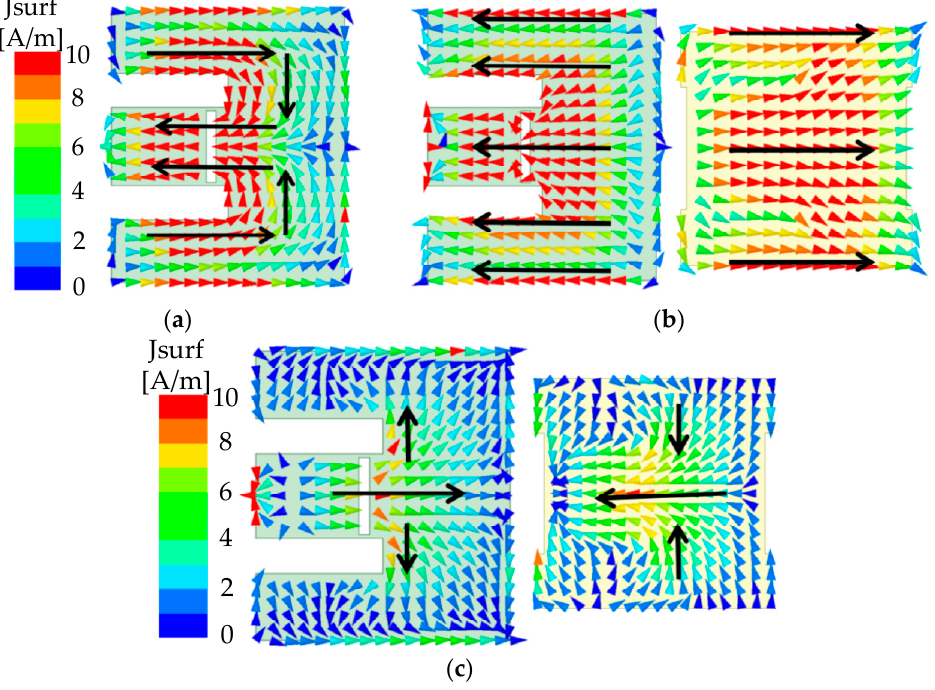
Figure 7. Current distributions and current paths of the three radiation nulls . ( a ) n 1 , 2.92 GHz; ( b ) n 2 , 4.1 GHz; ( c ) n 3 , 4.78 GHz.